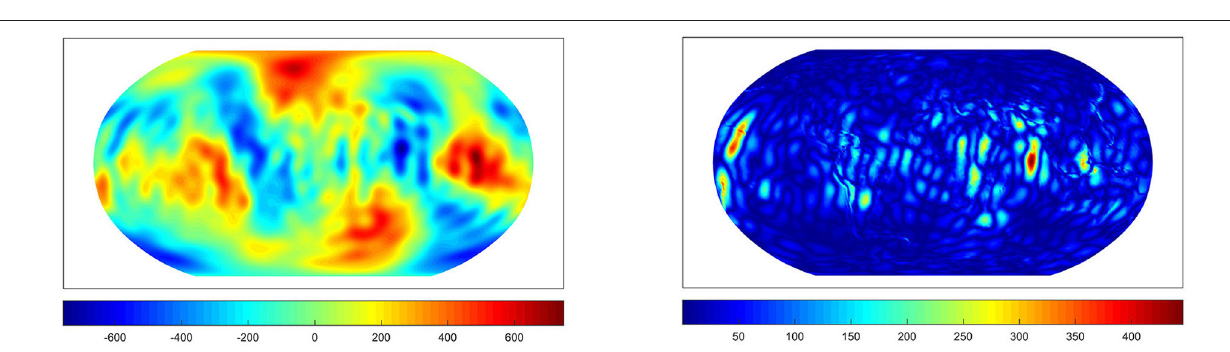
FIGURE 12 | The approximation from the RFMP for the parameter chosen by the MGCV (Left) and the difference to the EGM2008 up to degree 100 (Right) . Values in m 2 / s 2 . The inefficiency amounts to